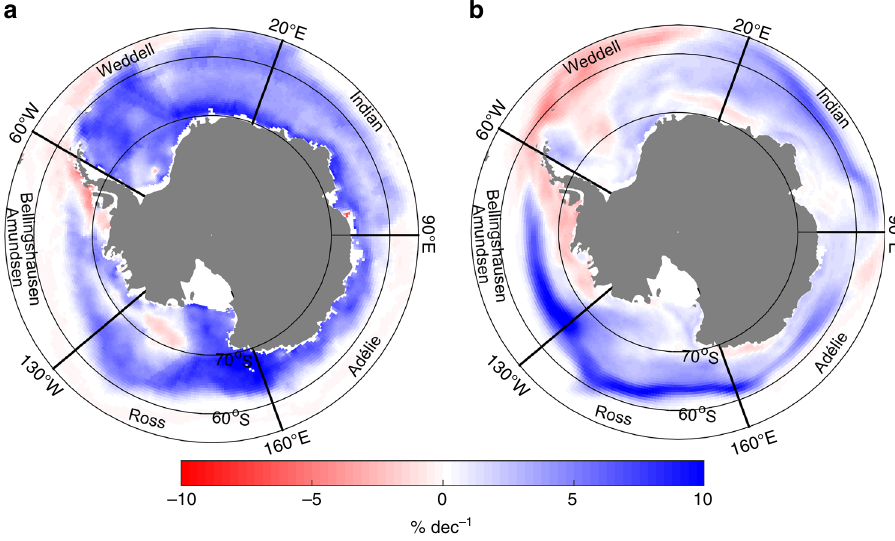
Fig. 1 Observed and simulated Antarctic sea-ice concentration trends. Observed 21 a and NEMO-LIM3.6-based b annual trends in Antarctic sea-ice concentration, computed over 1979 – 2014 and 1979 – 2013, respectively. All sectors of the Southern Ocean are de fi ned as in a previous study